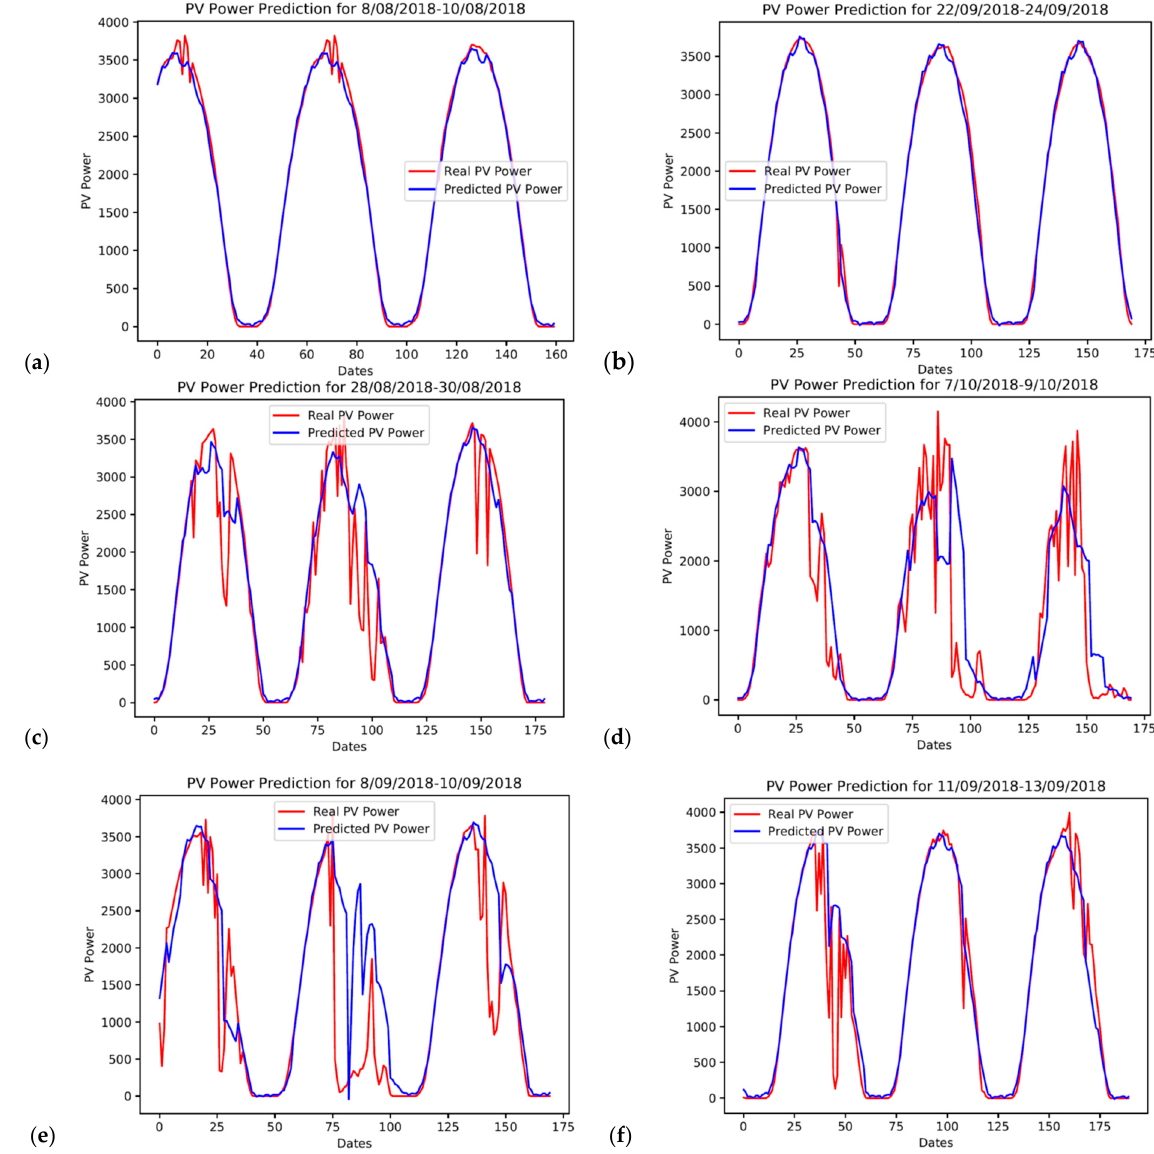
Figure 5. Actual PV power output signal (red line) and predicted PV power output signal (blue line) for some selected days